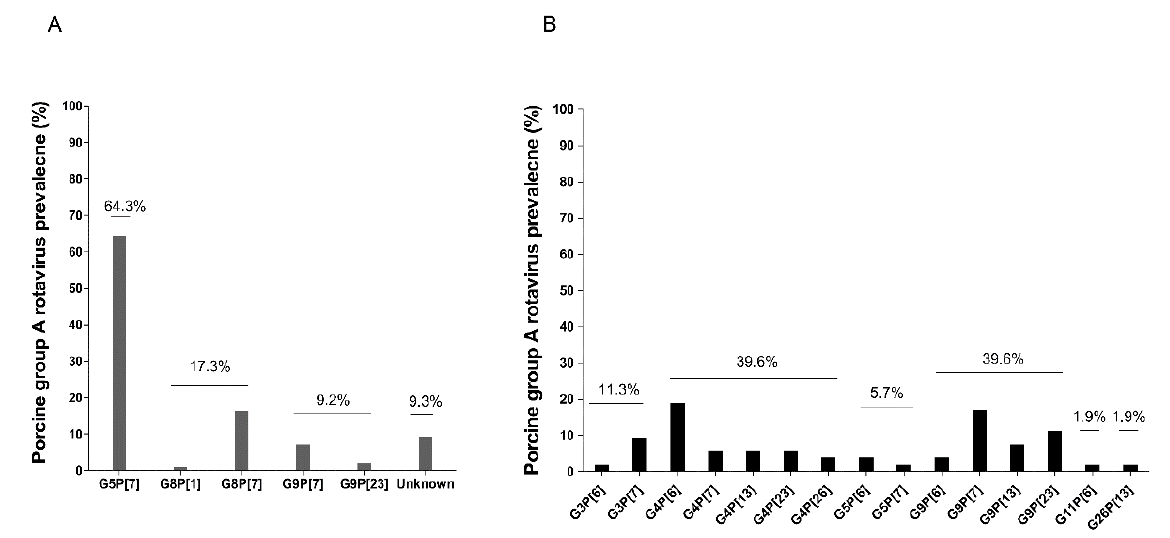
Figure 2. Comparison of the distribution of the G and P combinations of PoRVA strains that have circulated in pigs in South Korea. Distribution of the G/P combinations of PoRVA strains